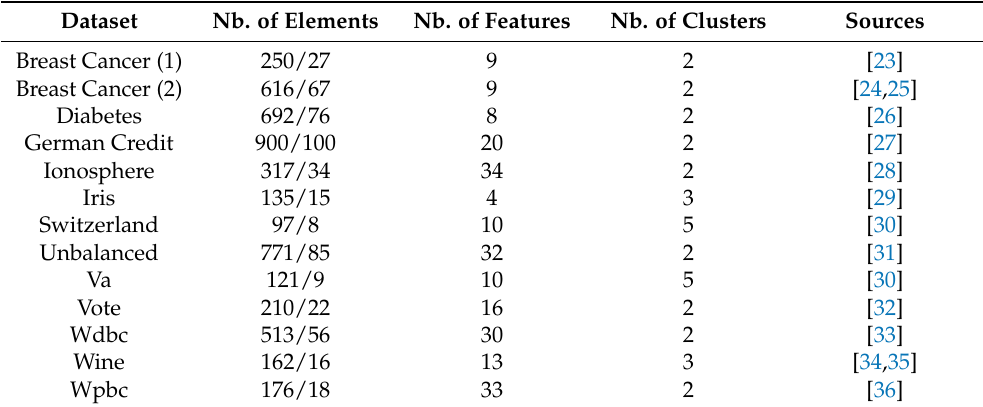
Table 2. Characteristics of the different training and test datasets used in this work.